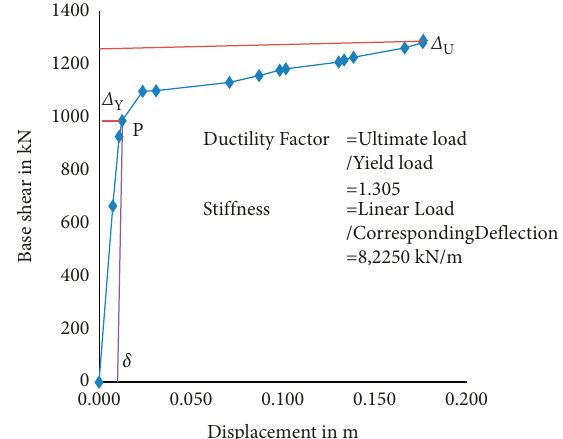
Figure 4: Bare frame in the X direction.